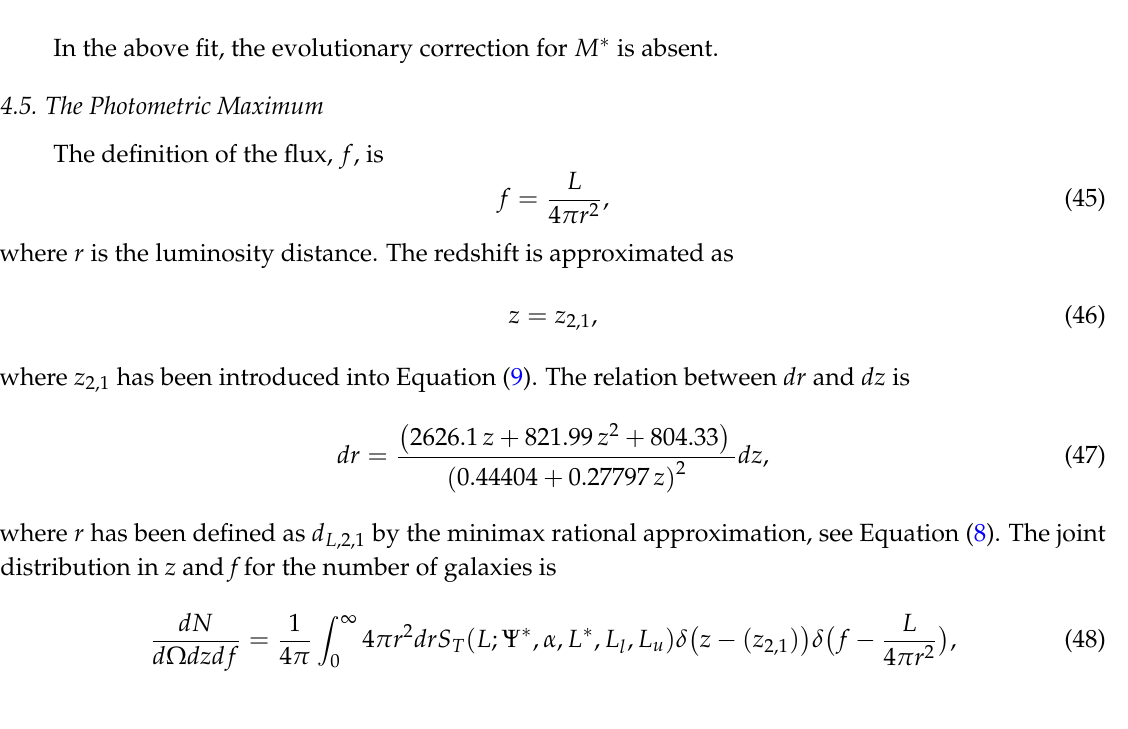
Figure 9. Average observed absolute magnitude versus redshift for QSOs (red points), average theoretical absolute magnitude for the Pei LF as evaluated numerically (dot-dash-dot green line), theoretical curve for the empirical lowest absolute magnitude at a given redshift, see Equation (42) (full black line) and the theoretical curve for the highest absolute magnitude at a given redshift (dashed black line), see Equation (37), RSS =